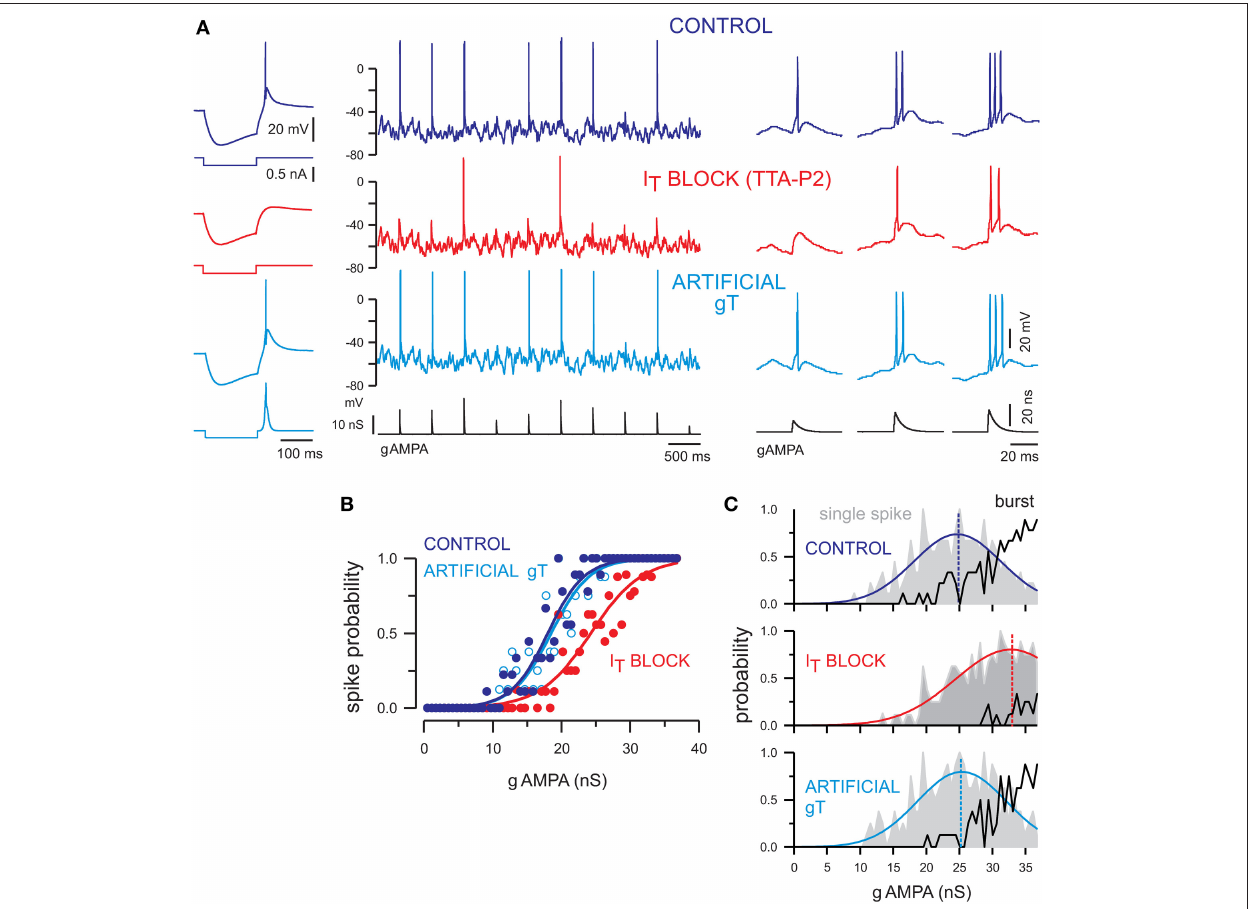
FIGURE 3 | T-current tunes the transfer function of TC neurons and contributes to single-spike and burst firing at depolarized membrane potentials. (A) Left panel. The rebound low-threshold spike evoked in a TC neuron following a hyperpolarizing current step (control condition) is blocked by TTA-P2 and restored by dynamic clamp injection of gT. Middle panel. Voltage traces of a TC neuron injected with a sequence of AMPA conductances (gAMPA) of different amplitudes in control condition and in the presence of TTA-P2. The neuron received the same fluctuating excitatory and inhibitory conductance noise in each condition and displayed a mean membrane potential of − 58mV. The smallest AMPA conductances failed to evoke a spike when the T-current was blocked (red) and the spike probability was restored upon artificial gT injection (light blue). Right panel. Zoom on the firing activity in response to gAMPA of increasing amplitudes from the recording shown on the middle panel. Both single-spike and burst responses were conditioned by the presence of the T-current. (B) Transfer functions of the neuron presented in (A) show that the T-current block shifted the input-output curve toward larger AMPA conductances [same color code as in (A) ]. Recovery was obtained with injection of gT. (C) Histograms present the probability of single-spike (gray area) and burst (black curve) generation as a function of the gAMPA amplitude in each condition. In the absence of T-current, the single-spike probability curve was shifted toward larger gAMPA and the burst probability was drastically reduced. The single-spike probability was fitted to a Gaussian function (colored line) to estimate the gAMPA conductance leading to the maximal probability (dashed line). Modified from Deleuze et al.